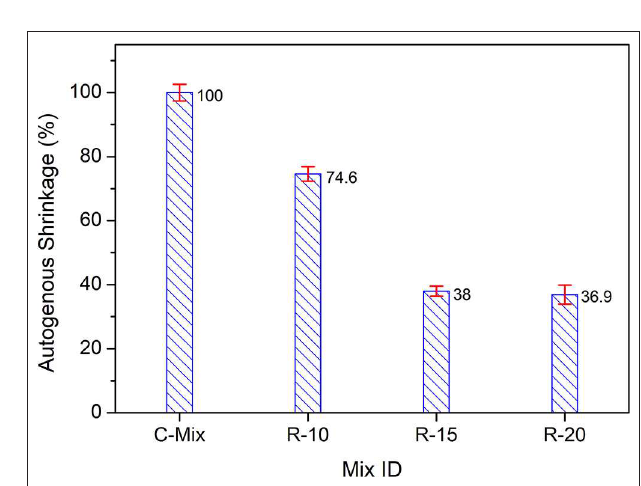
FIGURE 10 | Normalized autogenous shrinkage in RHA concretes R-10, R-15, and R-20 as a percentage of